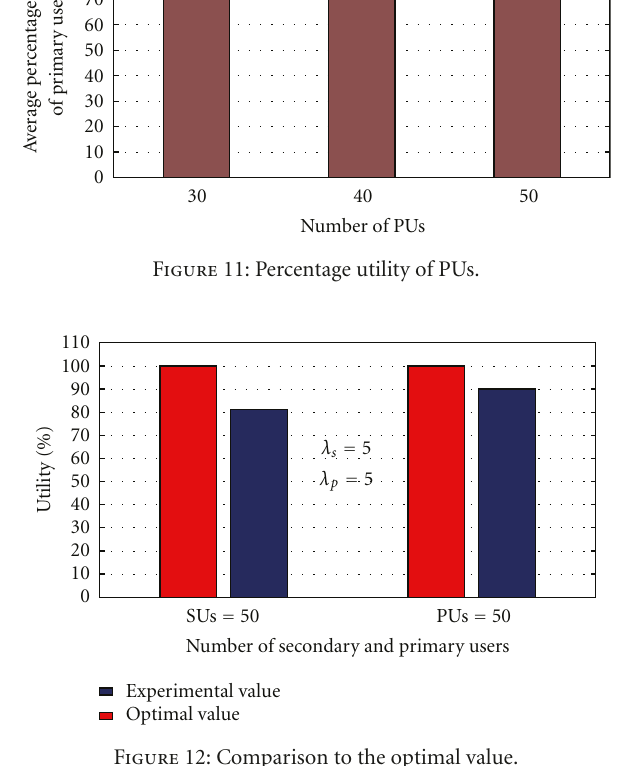
Figure 12: Comparison to the optimal value.